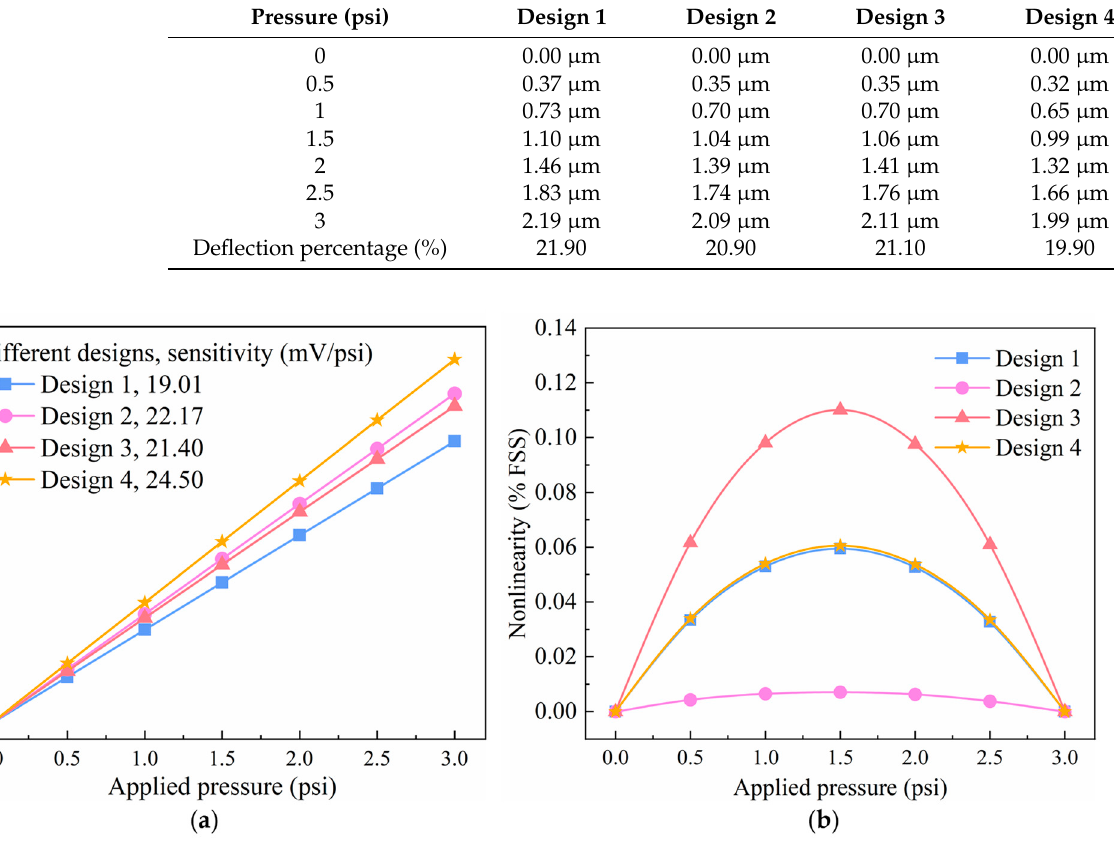
Figure 11. Comparison of the key performances for the four distinct designs: ( a ) the comparison of sensitivity and ( b ) the comparison of nonlinearity.